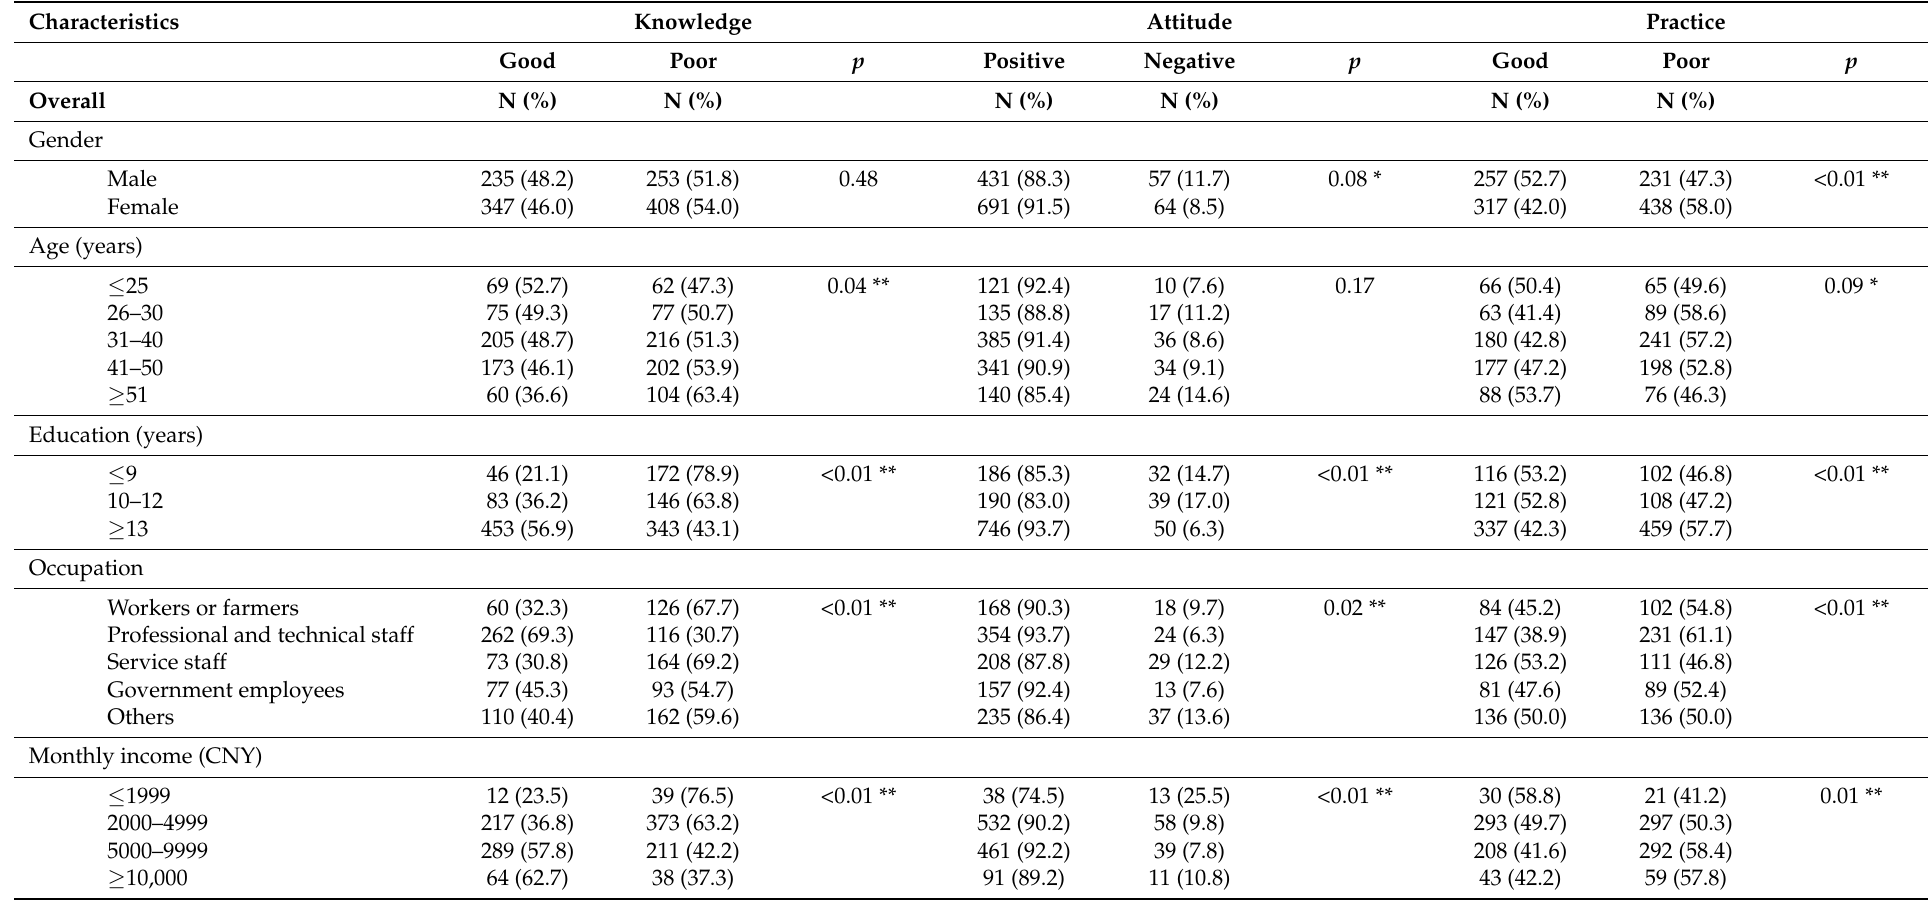
Table 2. Differences in knowledge, attitude and practice of Shanghai residents by demographics (N =